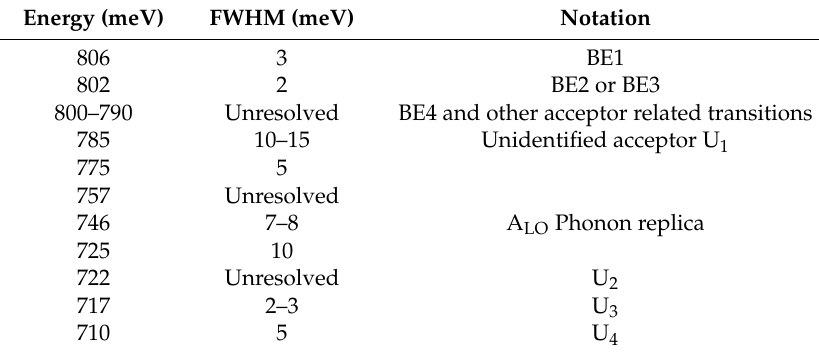
Table 4. Acceptor-related transitions of GaSb. Reproduced with permission from Lee et al., Journal of Applied Physics; published by the American Institute of Physics, 1986